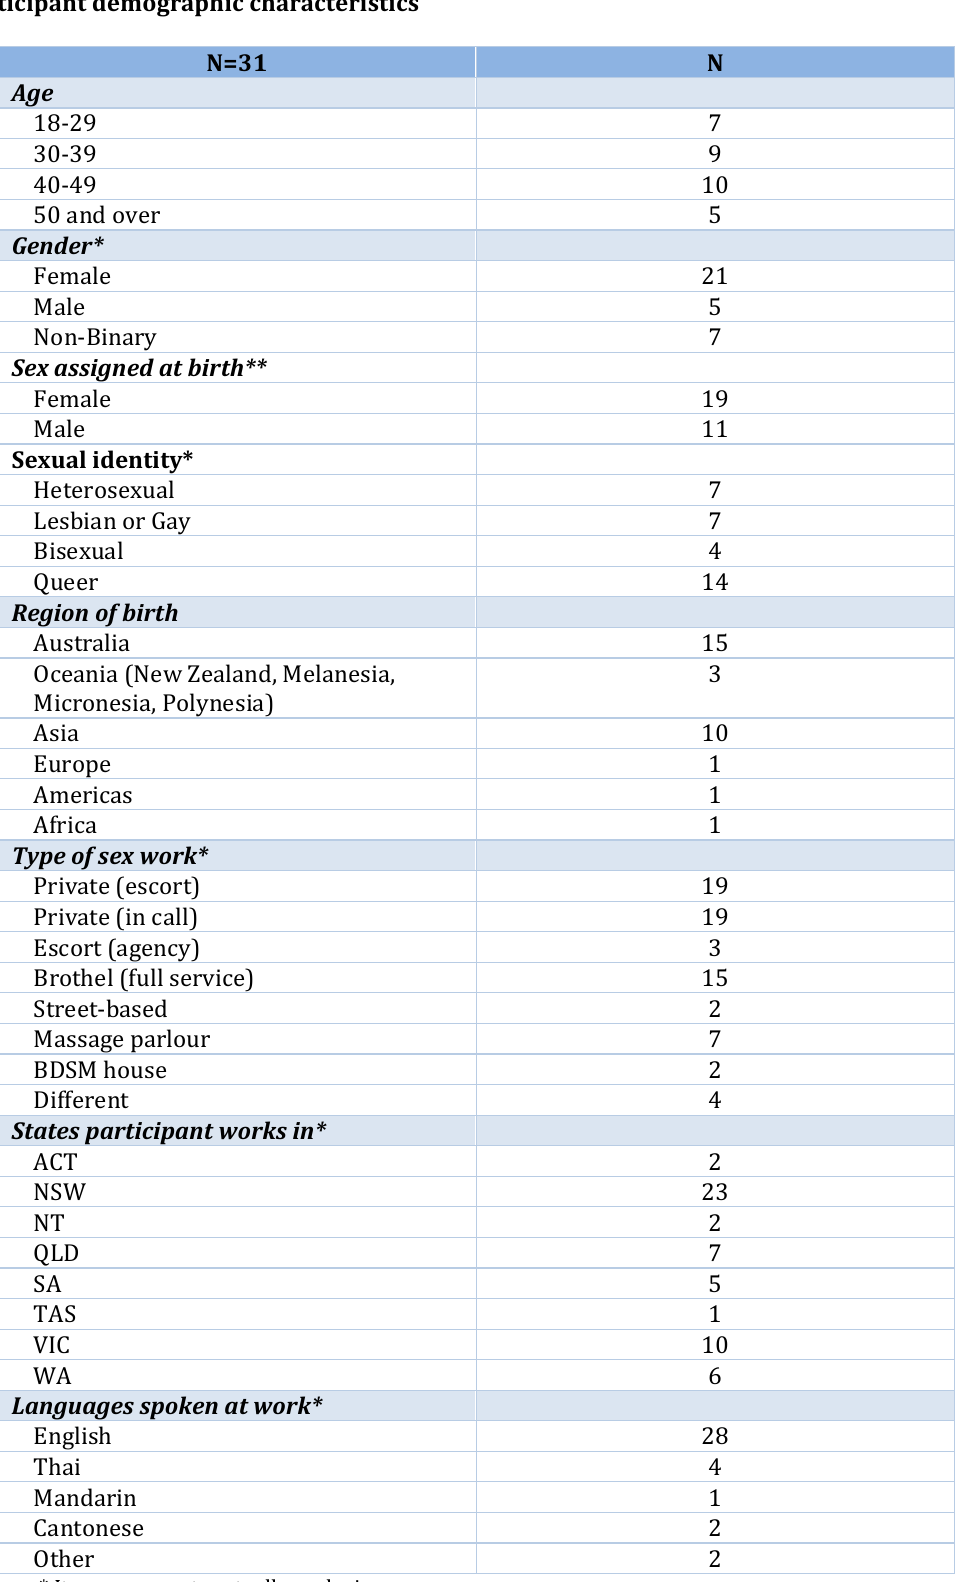
Table 1: Participant demographic